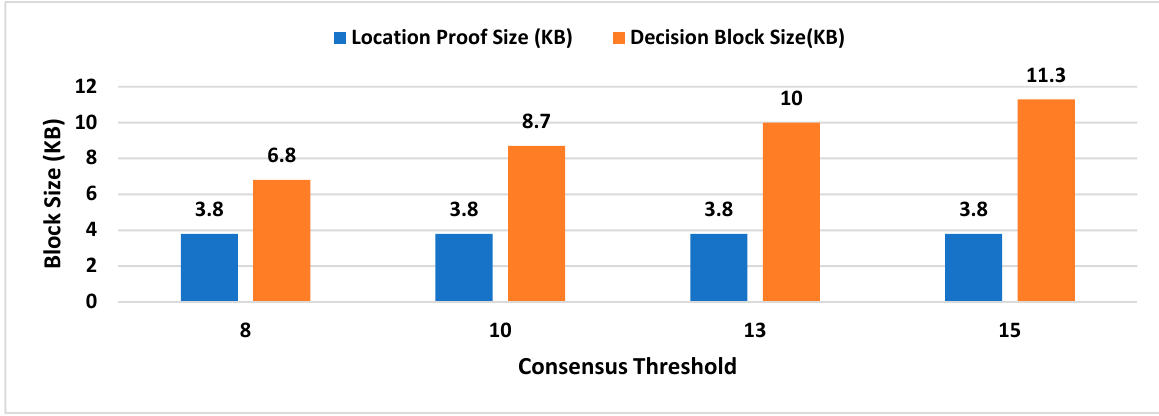
Figure 9. Consensus threshold impact on location proof size and decision block size.